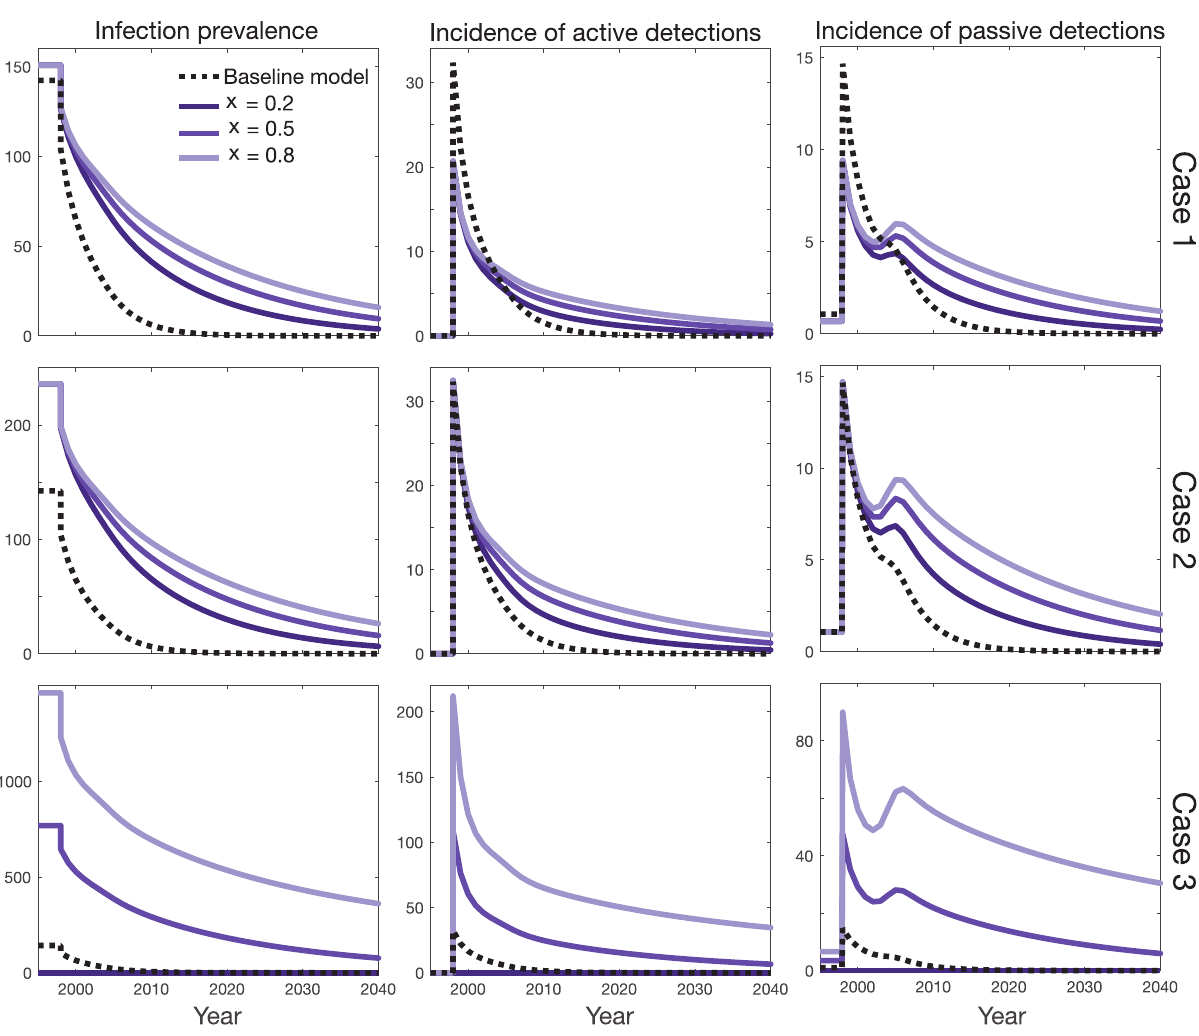
Fig 6. Influence of asymptomatic infection on infection dynamics. Total prevalence, active cases reported (without false-positive), and passive cases reported are plotted over the years 1998 to 2040. Each row corresponds to fixing either: (case 1) the basic reproduction number, R 0 , (case 2) the observable incidence of passive detections, or (case 3) the effective tsetse density, m . Different purple shades represent different values of relative skin- eff = 0.8, θ = 10 − 4 , o b ¼ 10 (cid:0) 5 , and o s ¼ 2 � 10 (cid:0) 4 are fixed. The baseline model is shown as a dashed black line only infection infectiousness, x , when p bs H H in each subplot ( p = 0 and o b ¼ 0 ). The prevalence and incidence are given per 10,000 bs H